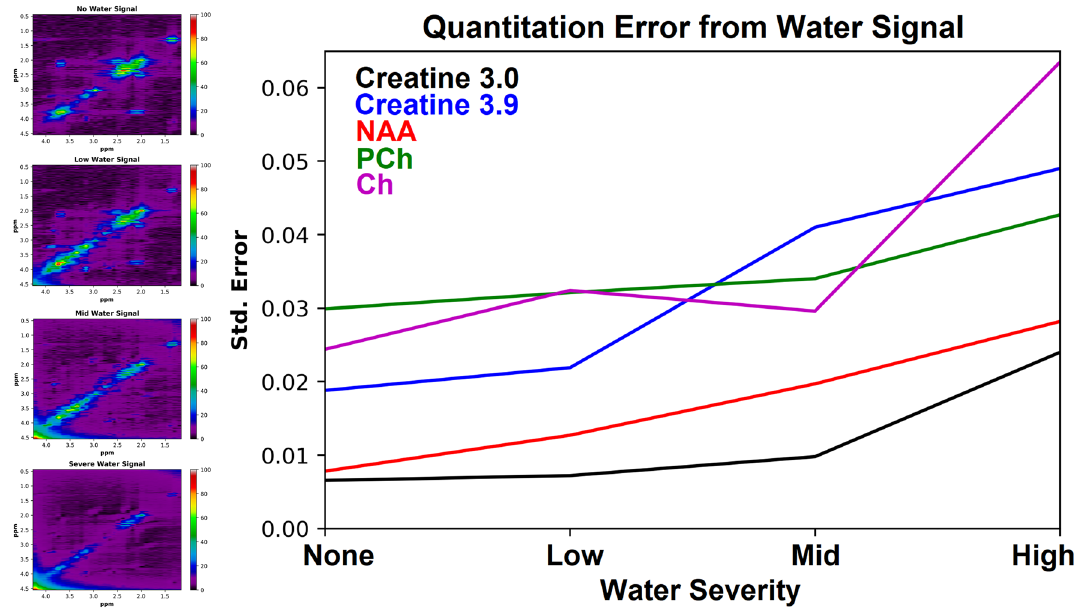
Figure 9. Water signal was introduced at different amplitudes to the spectra (left) to investigate how unknown signals impact D-UNet quantitation of the major metabolites. Standard error from fitting reconstructed and actual metabolite concentrations is displayed, and is higher as the water signal amplitude increases. Noise level = Metabolite